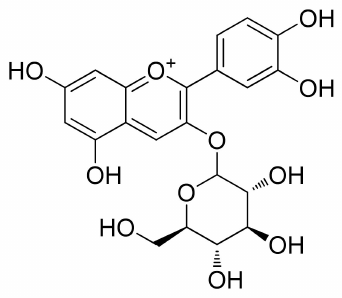
Figure 4. Chemical structure of cyanidin